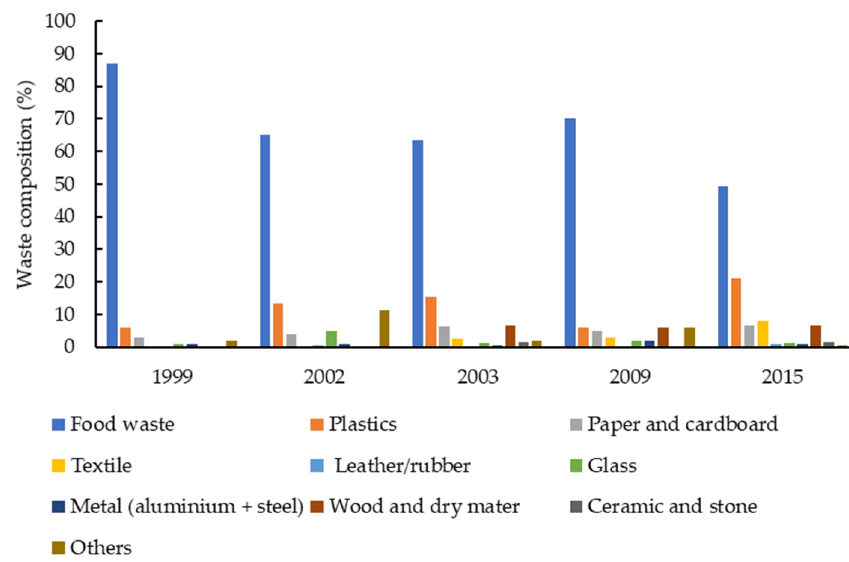
Figure 1. Waste composition in Phnom Penh municipality. Adapted from [12,33,34,38]. Table 2. Comparison of waste composition among